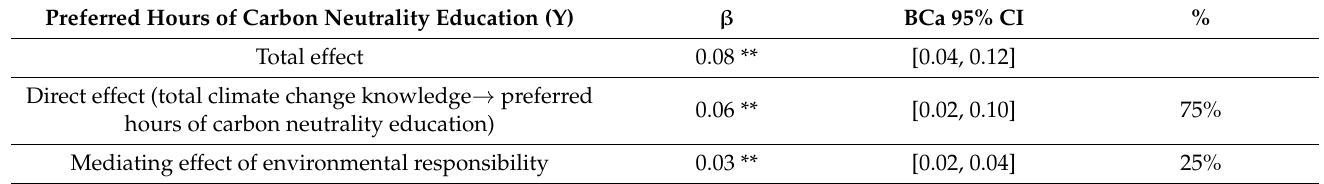
Table A8. Breakdown of total, direct, and mediating effects on preferred hours of carbon neutrality education by type of climate change